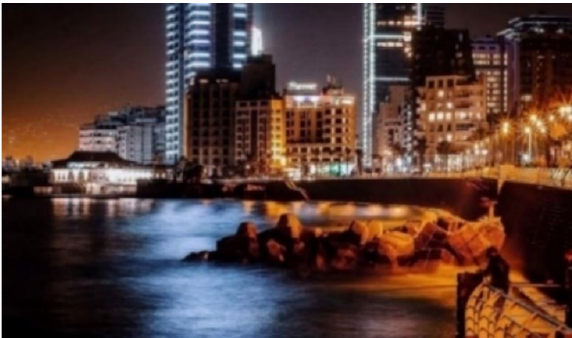
Figure 6. Photo in 2017 from the region of Ayn el Mreisseh, Beirut, to the Zeytuna Bay (Photo by Youssef Rached Doughan available at Beirut Heritage group, archived in 2017)